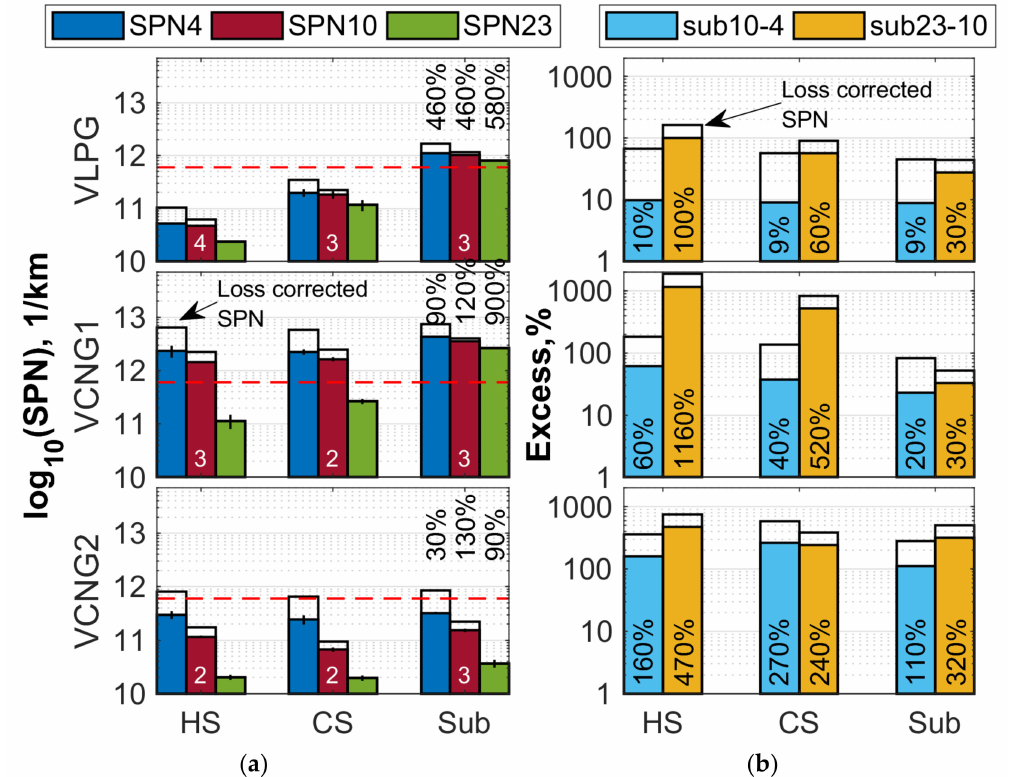
Figure 1. Solid particle number (SPN) emissions of the three vehicles VLPG (top), VCNG1 (middle) and VCNG2 (bottom) for 23 ◦ C hot start (HS), 23 ◦ C cold start (CS) and sub-zero (Sub) cold start WLTC for gaseous fuel operation: ( a ) SPN4, SPN10 and SPN23 emissions. Black edge bars represent the particle loss corrected values (see Section 2.2). Red dashed lines show the DI vehicle SPN-limit (6 × 10 11 1/km) (not applicable for the vehicles of this study). Black data labels (%) on left columns show the excess of SPN in sub-zero compared to cold start. White data labels show the number of repeats; ( b ) excess of SPN4 over SPN10 (sub10-4) and SPN10 over SPN23 (sub23-10). Black edge bars represent the excess after particle loss correction. Black data labels (%) show sub10-4 and sub23-10 for uncorrected